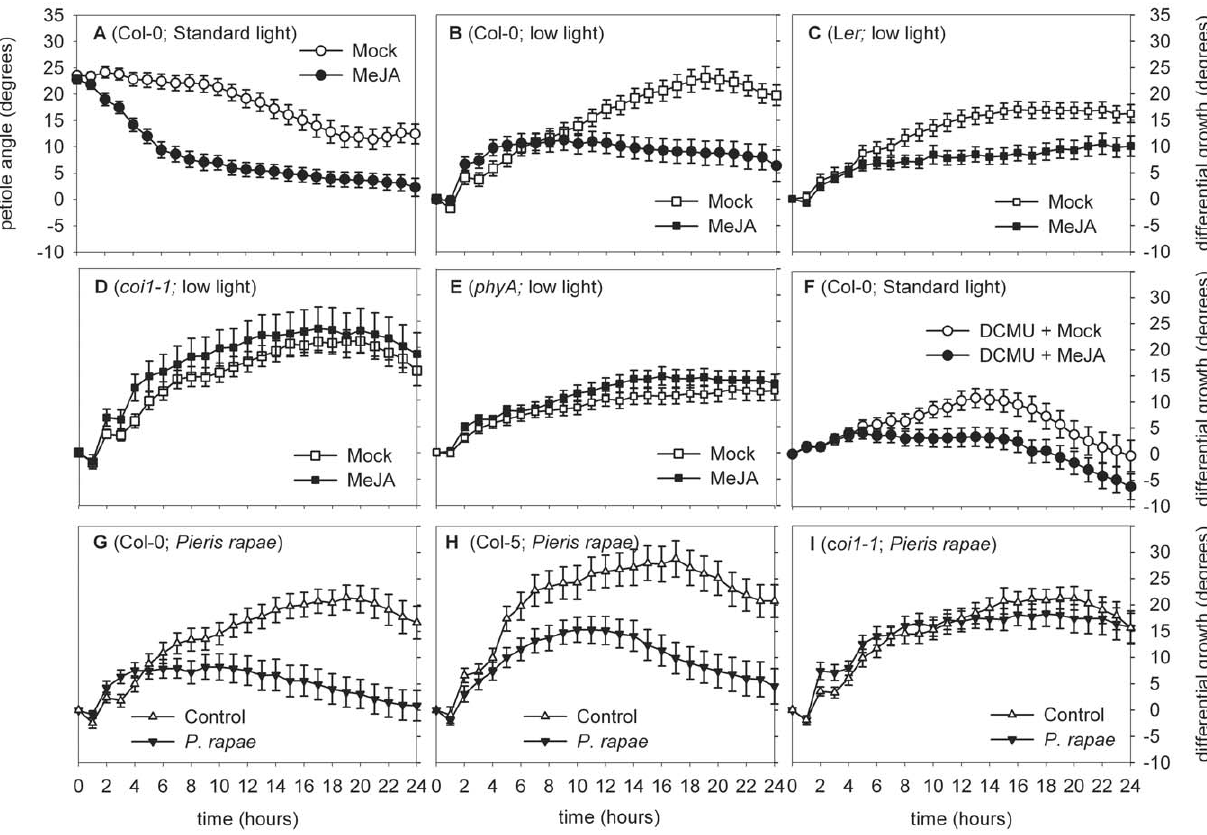
Figure 2. MeJA effects on light controlled leaf movements. (A–F) effect of (1 h) pre-treatment with 100 m M MeJA (closed circles), compared to mock (open circles), or (G–I) infestation with Pieris rapae (closed triangles) caterpillars compared to control (open triangles), on Arabidopsis petiole angles. Plants were (A,F) in standard light (200 m mol m 2 2 s 2 1 ) or (B–E,G–I): treated with low light (200 m mol m 2 2 s 2 1 to 15 m mol m 2 2 s 2 1 ). (A,B,G) Col- 0 wild type; (F) Col-0 wild type treated with 10 m M 3-(3,4-dichlorphenyl)-1,1-dimethylurea (DCMU); (D,I) coi1-1 ; (C) Landsberg erecta (L er ) wild type; (E) phytochrome A ( phyA-201 ) mutant (in L er ); (H) Col-5 wild type. Note that the Y-axis in panel (A) is different from the other panels (b–i) as here the angle relative to the horizontal is depicted, as opposed to (B–I) which shows pair-wise subtracted values per time point for the corresponding response in control conditions. Error bars represent SE, n . 12 petioles.